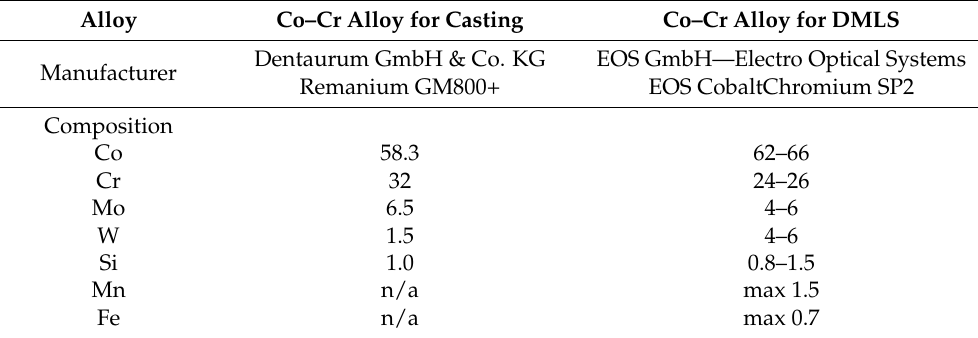
Table 1. Nominal chemical composition (in wt. %) of the used Co–Cr alloys.